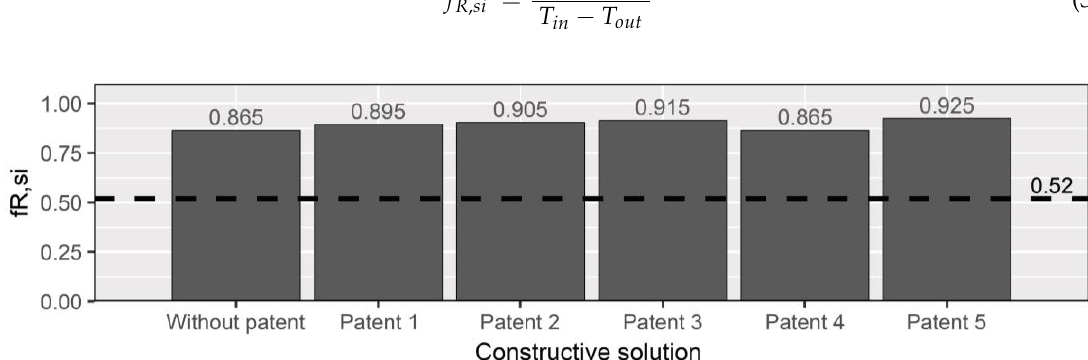
Figure 9. Internal surface temperature factor in all the assumptions. The minimum factor 𝑓 𝑅,𝑠𝑖 required by the technical standard in Spain is represented by black line.